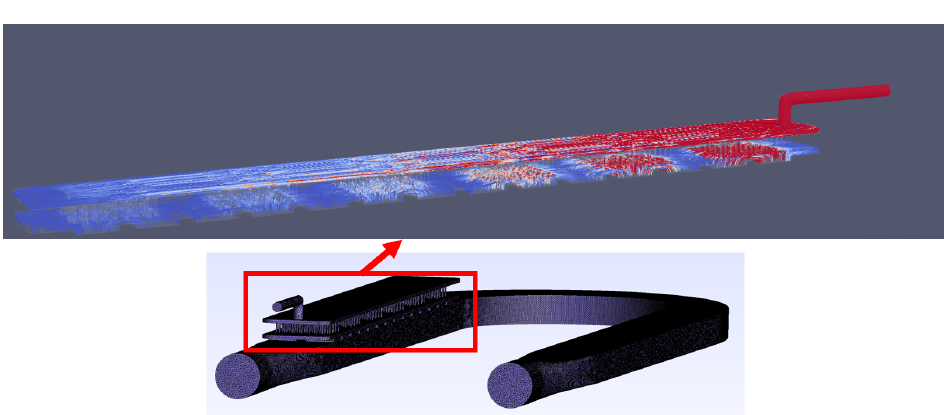
Figure 11. Entire loop. ( Top ): The colors denote the magnitude of fluid velocity with red denoting high velocity (maximum velocity is equal to 3.5 cm/s) and blue denoting low velocity (minimum velocity is 0 cm/s). ( Bottom ): The entire computational domain with mesh.